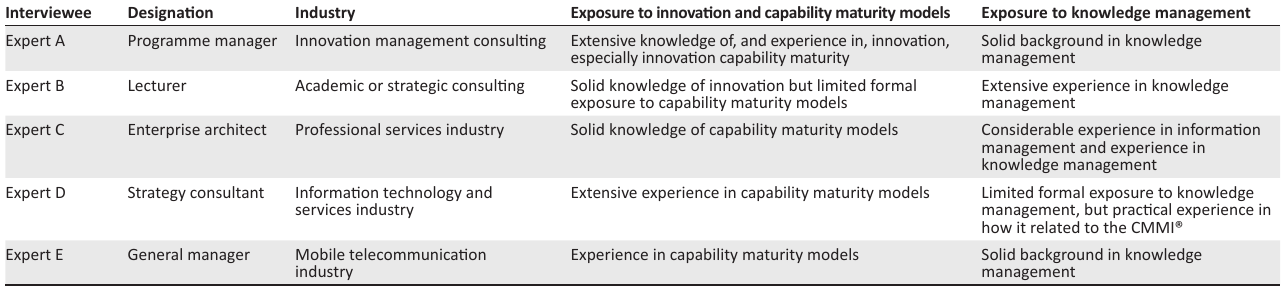
TABLE 1: Interviewees’ background in innovation and knowledge management.